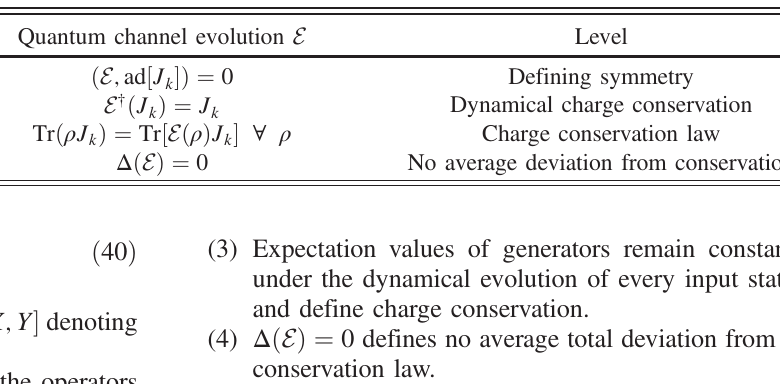
TABLE I. Definitions of symmetric dynamics and charge conservation for closed and open systems that are used throughout. For closed systems, 1 ⇔ 2 ⇔ 3 ⇔ 4 , while for open systems, 2 ⇔ 3 ⇔ 4 , but there is no such equivalence with respect to 1 (i.e., defining symmetry). A symmetric dynamics is one that commutes with the action of the generators. Here, ad ½ J given by Eq.